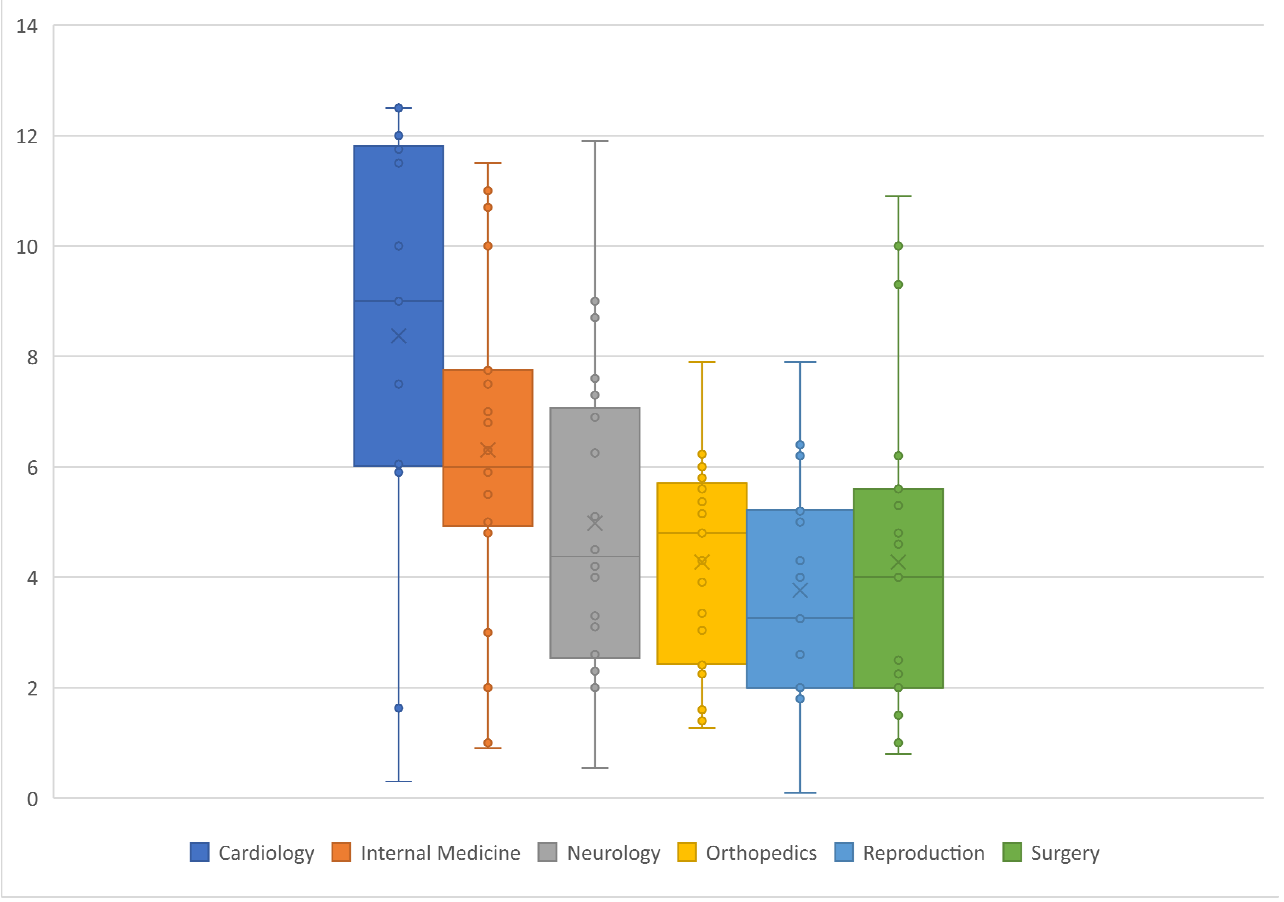
Figure 3. Age (in years) of the dogs utilized in 150 clinical trials within six veterinary specialties (25 each).